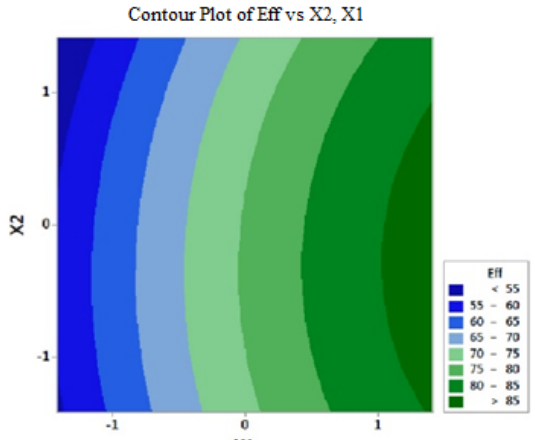
Fig. 3: Contour plot of efficiency in terms of X1 and X2